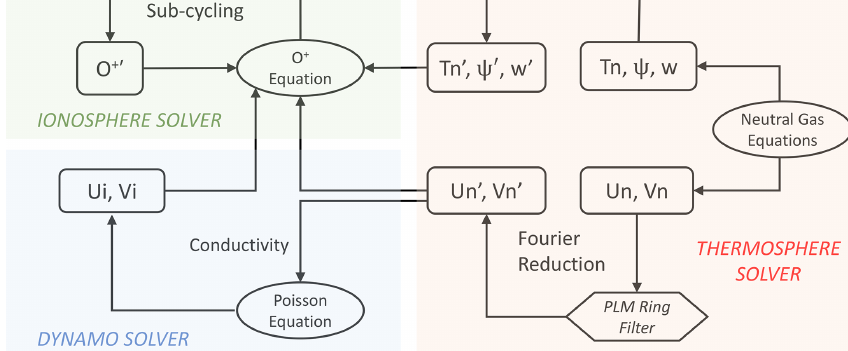
Figure 5. The main ring average algorithm in the TIEGCM.